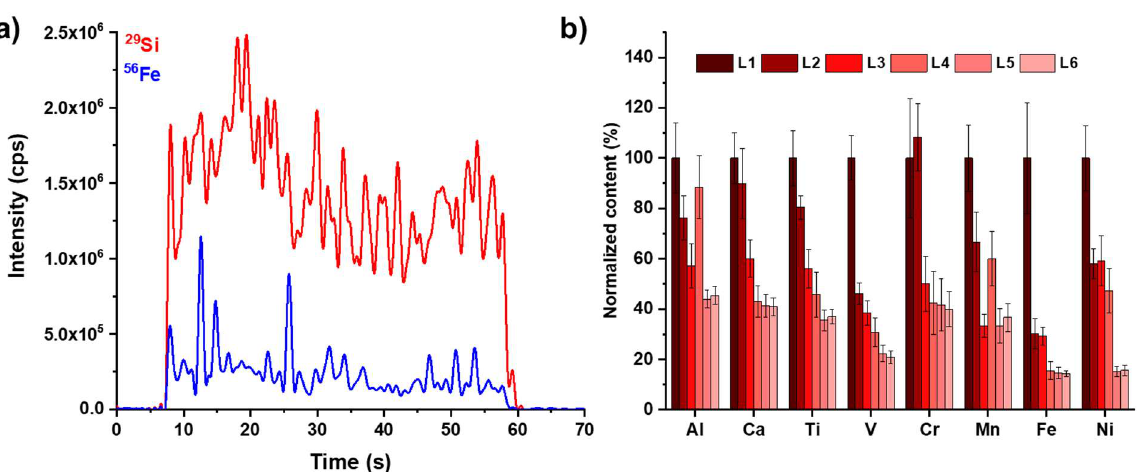
Figure 1. ( a ) Examples of ablation signals over a 2 mm long line and ( b ) depth profile analysis of the selected elements. Both measurements were carried on the standard reference material BAM S003a: the relative amounts of trace elements reported in ( b ) are determined using 29 Si as the internal standard.